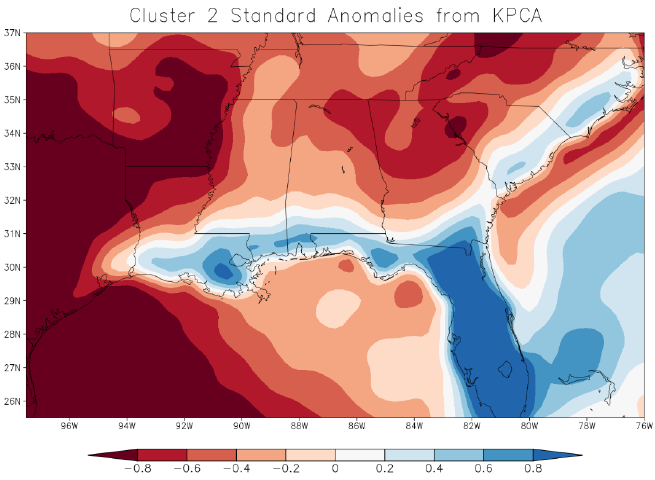
Figure 7. Cluster 2′ s 15-day precipitation standard anomalies derived from KPCA-preprocessed cluster analysis. This pattern was slightly different than the one with no KPCA-preprocessing as 2005 was not included as part of this composite.